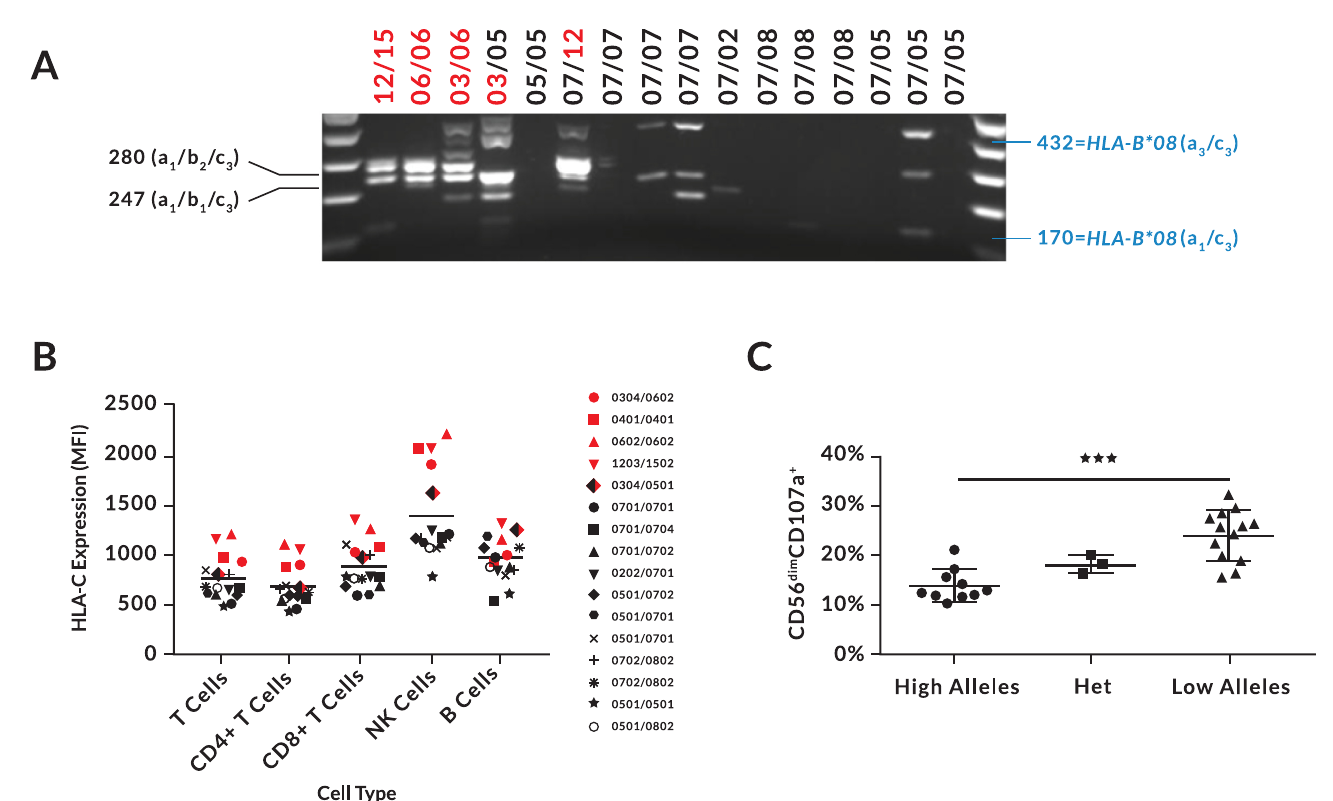
Fig 7. A disrupted Ets-binding site decreases NK-Pro transcription and HLA-C expression, resulting in higher lytic activity of NK cells. (A) RT-PCR performed with NK-Pro specific primers on purified NK cell RNA. The HLA-C genotype of each donor is listed above each lane. Red type indicates an allele that possesses an intact Ets site, whereas those in black type have a disrupted site. The size and exon content of the most abundant HLA-C transcripts is listed on the left, and two examples of HLA-B (cid:3) 08 transcripts detected are shown on the right. (B) Expression levels of HLA-C on peripheral blood lymphocytes is shown. Red symbols represent donors containing an intact Ets site, and black symbols are donors with disrupted Ets sites. (C) Summary of CD107a expression on CD56 dim NK cells after a 5-hour incubation with 721.221 target cells. Data shown are a summary of the results of four separate experiments testing 4–9 donors each time. HLA-C genotypes of individual donors are listed on the x-axis. (High) indicates donors homozygous for HLA-C alleles with an intact Ets site, (Low) indicates donors homozygous for a disrupted Ets site, and (Het) are individuals possessing one allele of each type. The line marked with ( (cid:3)(cid:3)(cid:3) ) indicates p < 0.001 for the difference between high and low donors using a Mann-Whitney ranked sum